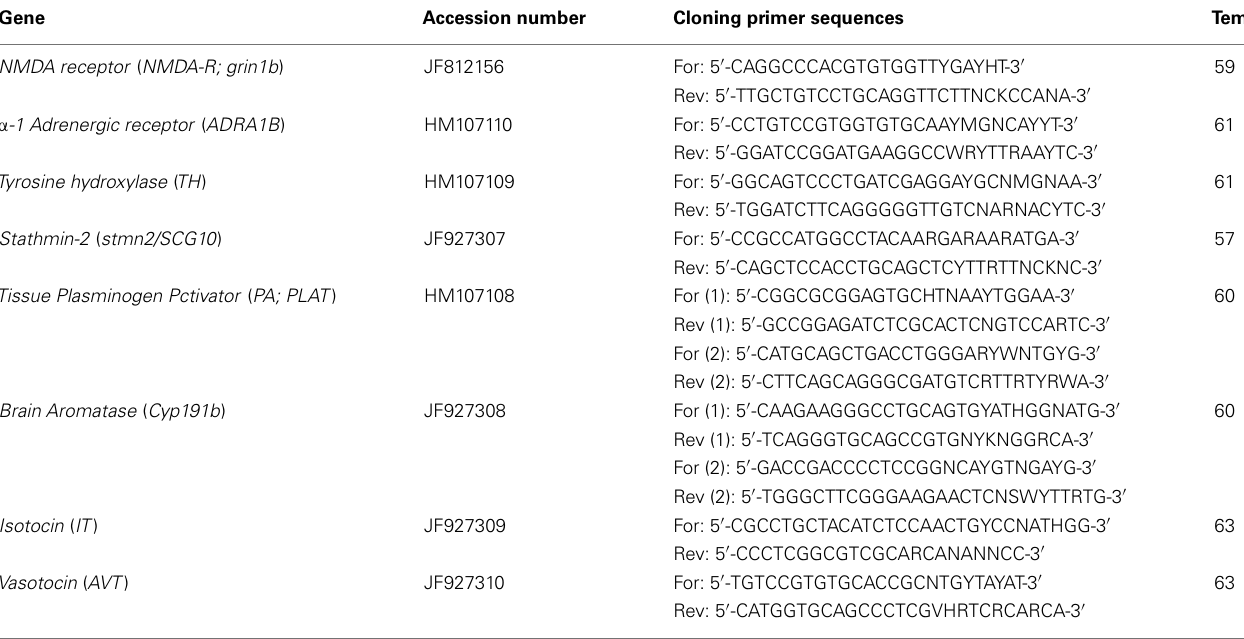
TableA1 | Cloning primers and accession numbers.